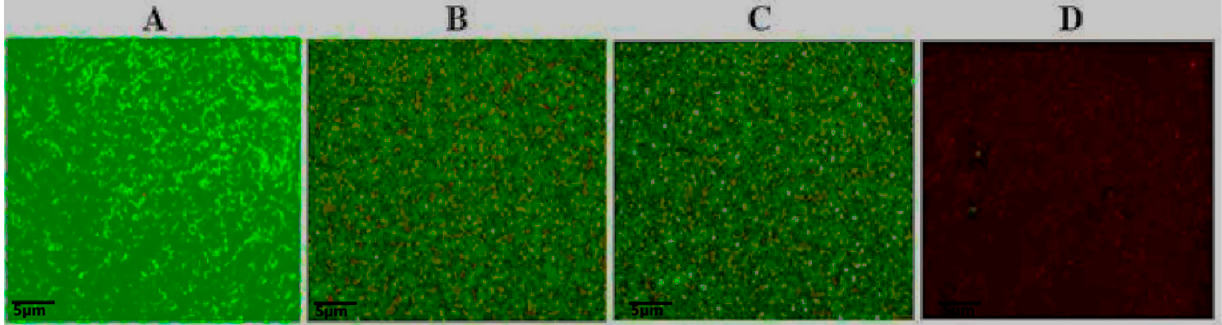
Figure 2. Colistin and tetrandrine, in combination, kill colistin ‐ resistant E. coli . Fluorescence micro ‐ scopic observation of ( A ) control: cells growing in the absence of colistin and tetrandrine. ( B ) Col ‐ istin alone does not inhibit the growth of E. coli , ( C ) tetrandrine alone does not inhibit the growth of E. coli , and ( D ) cells treated with colistin plus tetrandrine in combination show numerous dead cells.